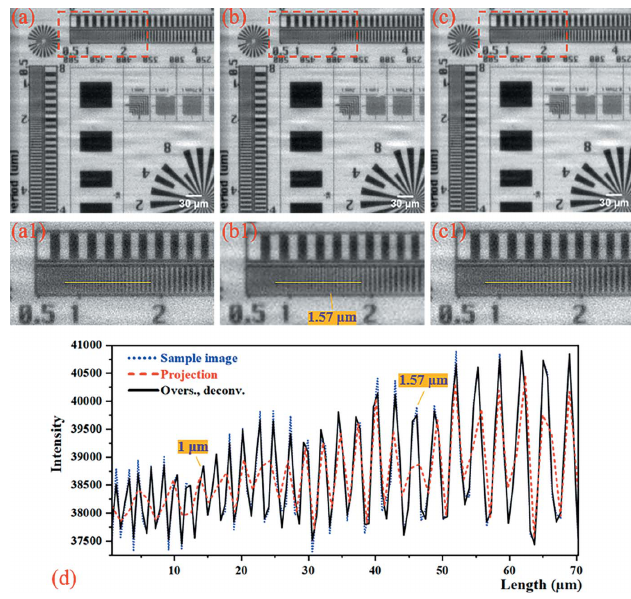
Figure 4 Results of the 2 (cid:2) 2 mode numerical simulation experiment. ( a ) The sample image (pixel size: 0.65 m m (cid:2) 0.65 m m; pixel number: 588 (cid:2) 588). ( b ) The projection (pixel size: 1.3 m m (cid:2) 1.3 m m; pixel number: 294 (cid:2) 294). ( c ) The oversampled image with deconvolution (pixel size: 0.65 m m (cid:2) 0.65 m m; pixel number: 588 (cid:2) 588). Panels ( a )–( c ) are only part of the image to show the details more clearly. Panels ( a 1)–( c 1) correspond to the magnified images in the red boxes of ( a )–( c ), respectively. ( d ) The intensity profiles at the yellow line of ( a 1)–( c 1). It is important to note that the numbers marked on the image represent the line-width. The numerical annotations on all subsequent figures refer to the line-width.